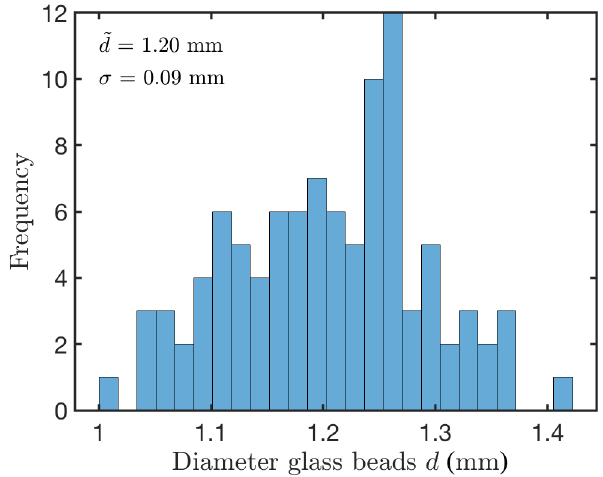
Figure D1. Size frequency distribution of the glass bead diameters. In addition to the distribution, both the arithmetic mean (cid:101) d and stan- dard deviation σ are given.